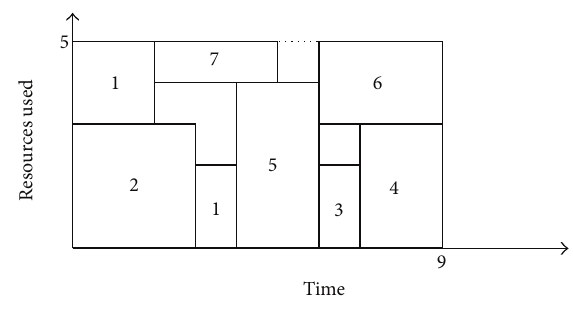
Figure 3: The optimal preemptive